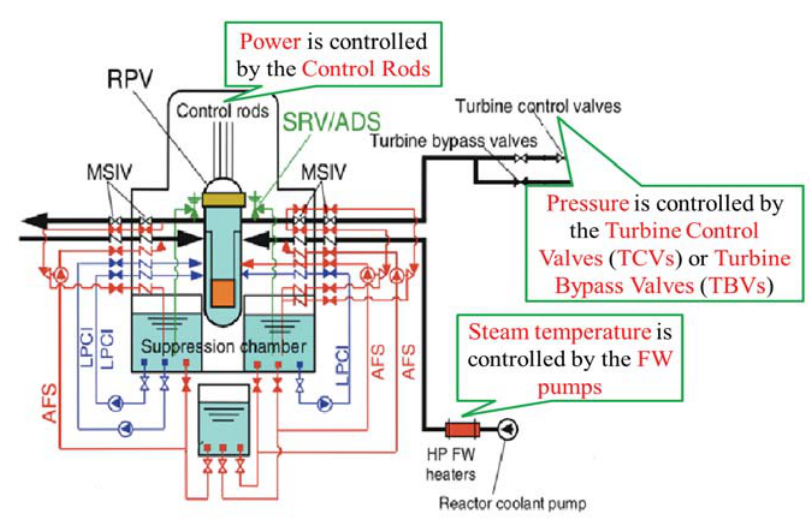
Figure 1: Plant control and safety system of Super FR [13]